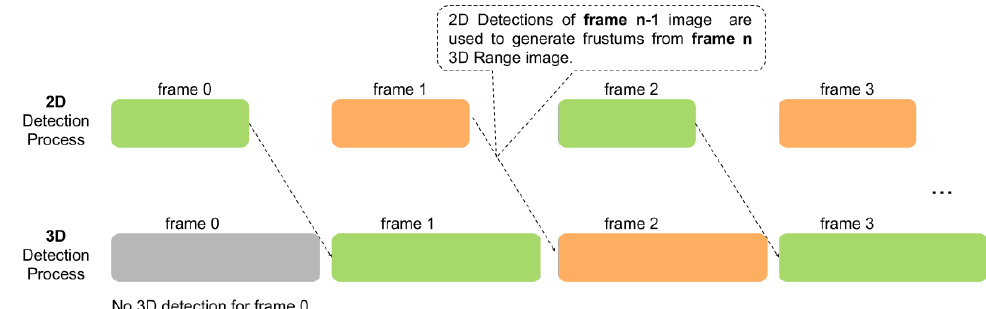
Figure 8. Illustration of using pipelining to speedup the whole detection